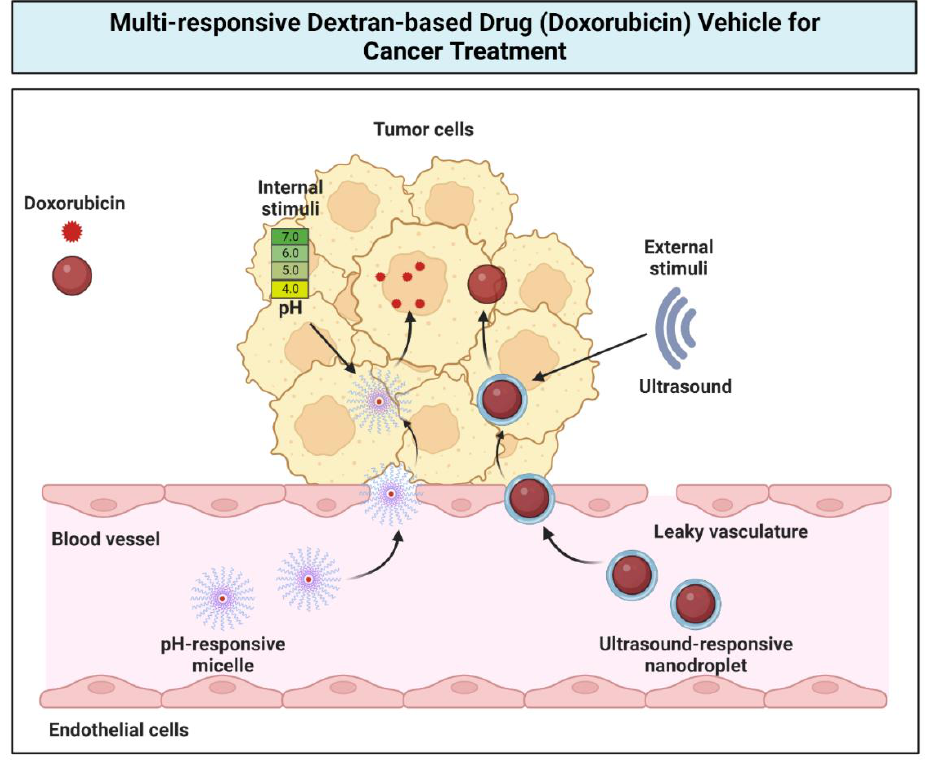
Figure 8. Multi-responsive dextran-based drug delivery vehicle to deliver doxorubicin (DOX) drug for cancer treatments. DOX is loaded into dextran-based micelles that are responsive to internal stimuli (i.e., changes in the pH tumor environment). DOX also can be loaded into a dextran-based nanodroplet that is responsive to external stimuli such as ultrasound. This multi-responsive DDS allows drugs to be delivered in a more targeted manner such as in tumor cells. The micelles and nanodroplets enter the tumor environment through leaky vasculature. DOX will only be released into the tumor cells upon response to pH changes or ultrasound stimuli. Table 6. Summary of studies on dextran-based